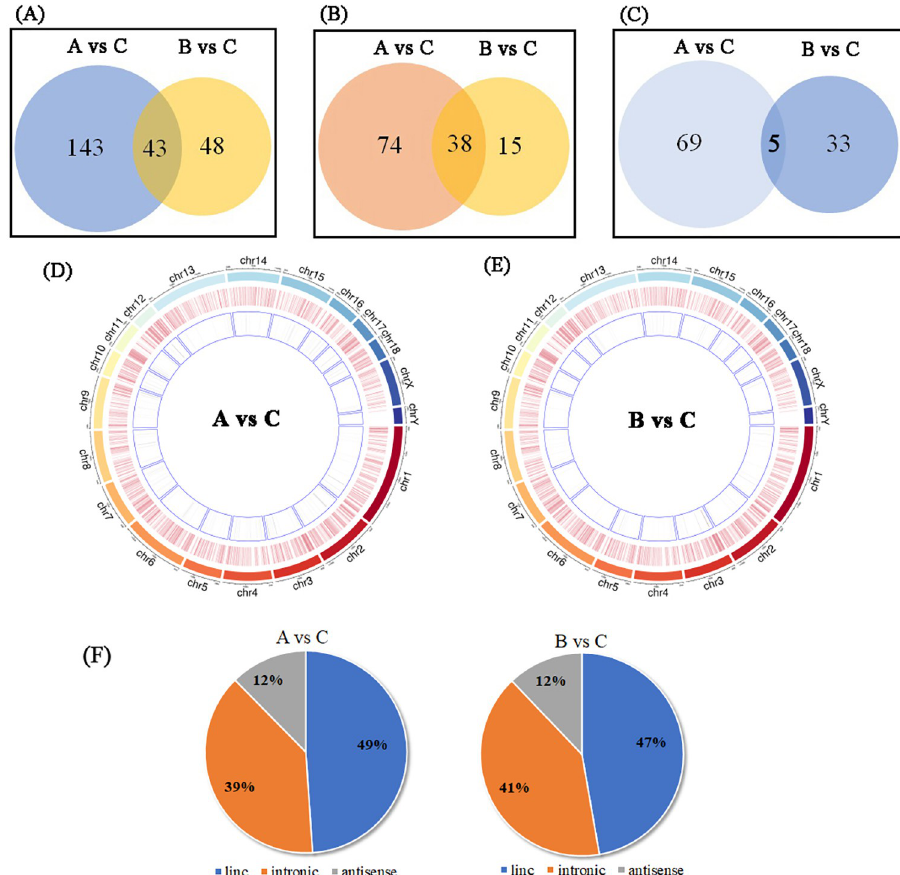
Fig 3. Differentially expressed lncRNAs in the skeletal muscle of the Min pig under cold stress. A. Total differentially expressed lncRNAs in the chronic low-temperature acclimation group and acute short cold stress group (log 2 FC > 1 and q < 0.05). B. Upregulated differentially expressed lncRNAs in the chronic low-temperature acclimation group and acute short cold stress group. C. Downregulated differentially expressed lncRNAs in the chronic low-temperature acclimation group and acute short cold stress group. D. The distribution of lncRNAs on pig chromosomes for chronic low-temperature acclimation group. The maximum circle represents the chromosome length of the pig genome; the second circle represents all lncRNAs detected in this experiment, and the smallest circle represents the significantly differentially expressed lncRNAs (|log 2 FC| > 1 and q < 0.05). E. The distribution of lncRNAs on pig chromosomes for acute short cold stress group. The means of every circle is same to D. F. The proportions of three categories lncRNAs for chronic low-temperature acclimation group and acute short cold stress group.